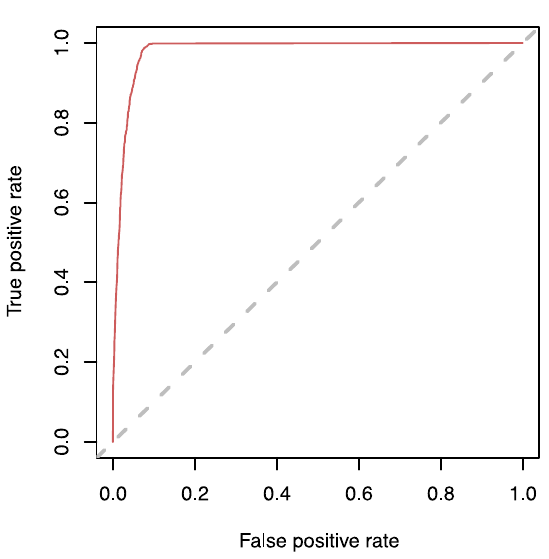
Figure 4. Uncertainty in estimates for simulated data (fossil- ized birth-death process). The graph shows the widths of relative 95% HPD intervals of the turnover rate, n , against tree sizes for simulated fossilized birth-death process. The black dots are the interval widths for posterior distributions obtained from the analyses of simulated sequence data of all sampled nodes and the red triangles are the interval widths from the analyses of sequence data of only extant samples.